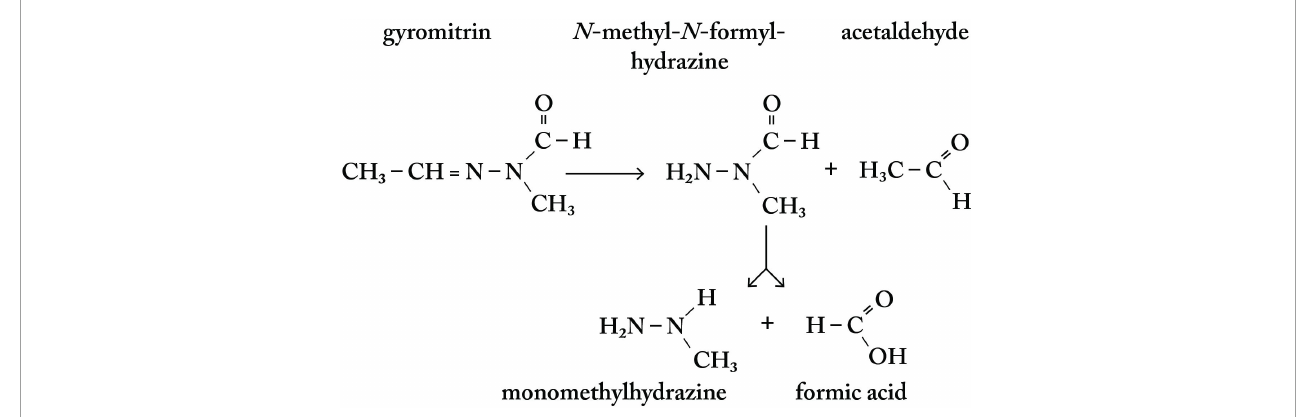
FIGURE5 Metabolic pathway to monomethylhydrazine (MMH) of the major hydrazone gyromitrin in G. esculenta . MMH has acute neurotoxic properties but, like cycad-derived methylazoxymethanol, also induces DNA lesions ( O 6 - and N 7 -methylguanine) that are poorly repaired in neurons and are proposed to result in multiple downstream cellular effects linked to neurodegenerative diseases, such as